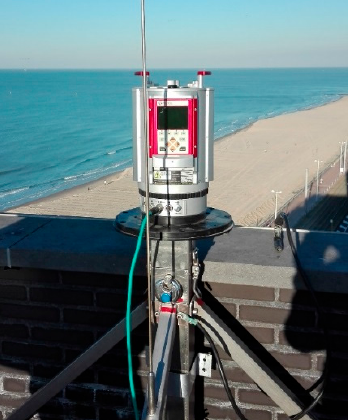
Figure 4. Set-up of the permanent terrestrial laser scanner at the study site.